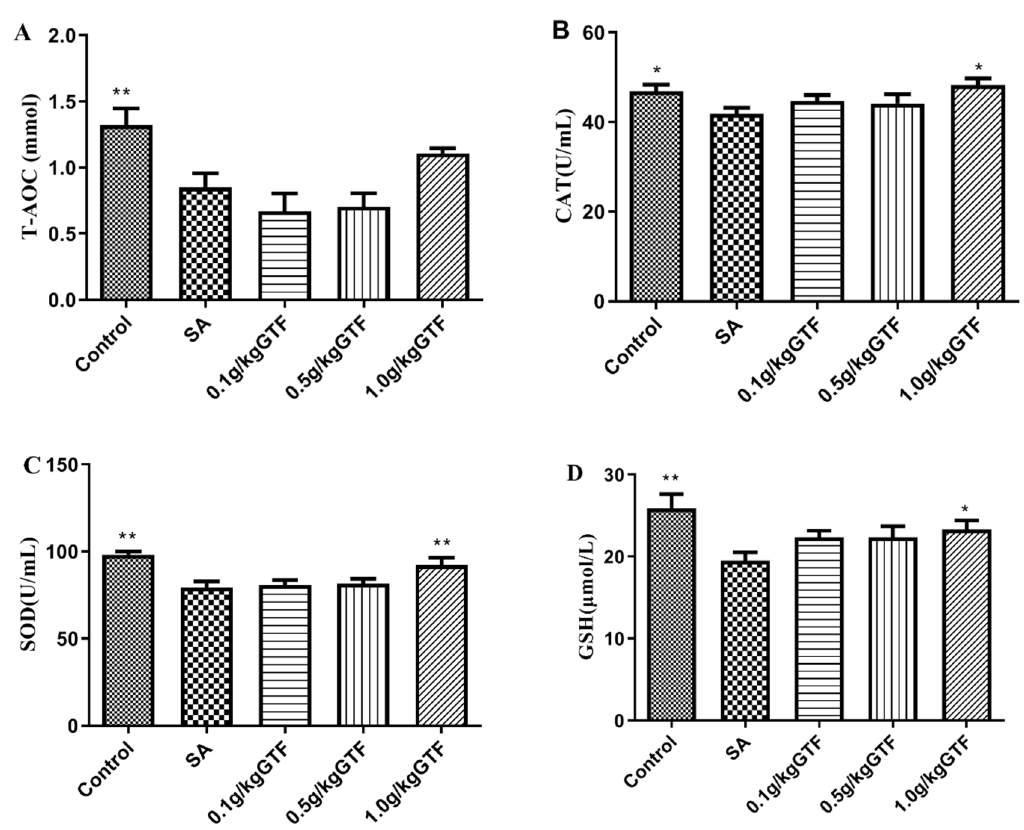
Figure 3. Effects of GTF on the activities of T-AOC ( A ), CAT ( B ), SOD ( C ) and GSH ( D ) in the serum of tilapia. Values are expressed as the mean ± SEM ( n = 10). * p < 0.05; ** p < 0.01, compared with the streptococcal injection group.